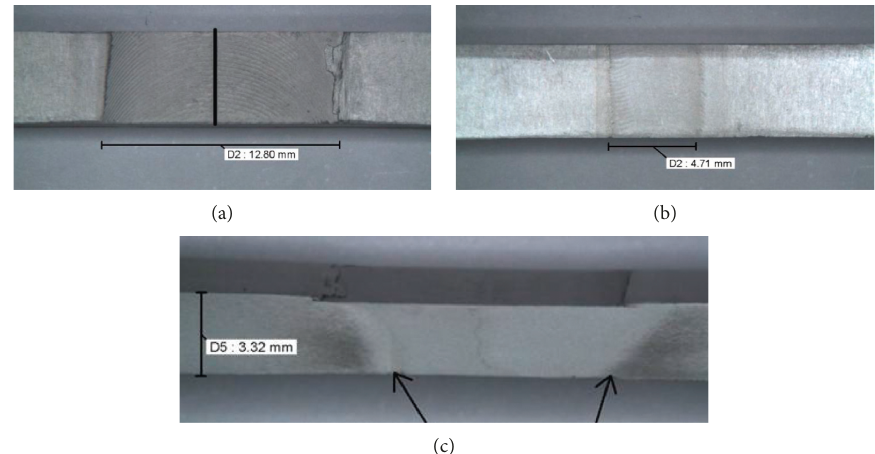
Figure 2: Macroscopic images of a friction stir welded sample showing (a) weldment top view (black line indicates the weld center), (b) weldment bottom side (root), and (c) weldment